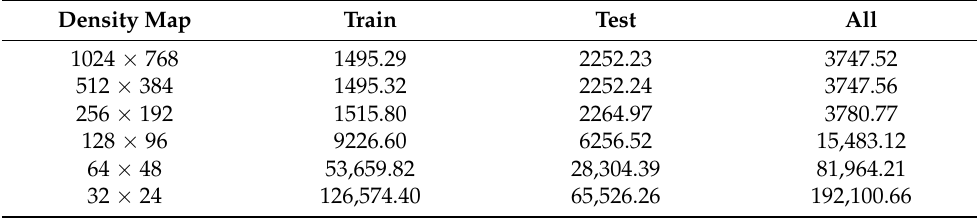
Table 1. Density map label error with different downsampling operations. Density